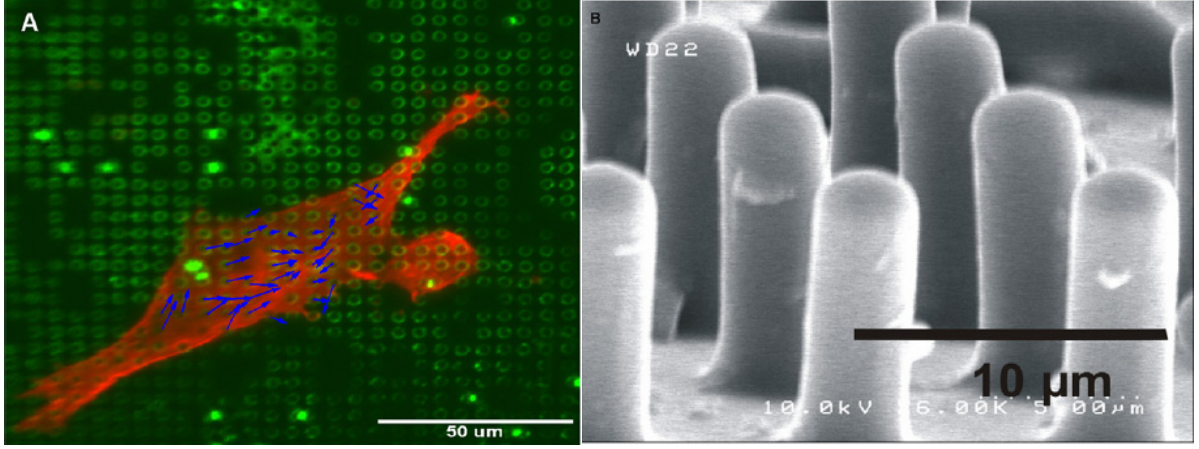
posts. B) SEM of profile of section of BoN 2 μ m in diameter, 5 μ m spacing and 7 μ m tall